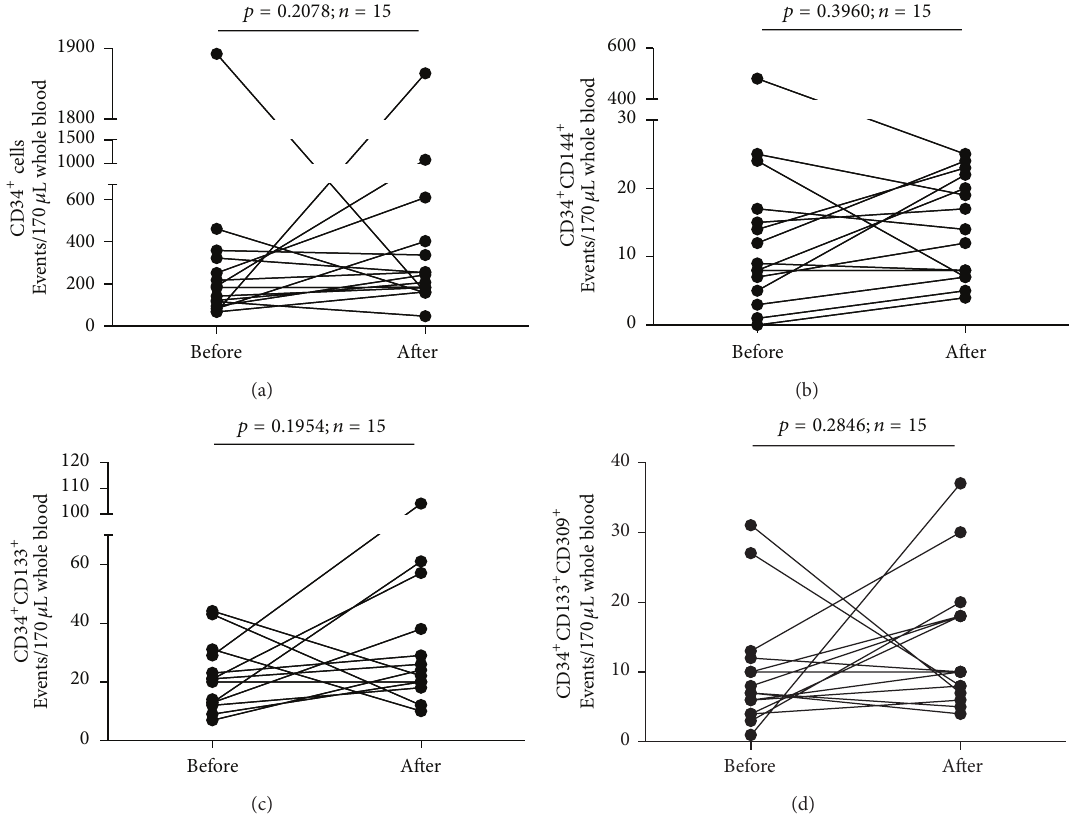
Figure 4: Summary of analyses of time-course changes of the numbers of CD34 + cells (a), CD34 + CD144 + cells (b), CD34 + CD133 + cells (c), and CD34 + CD133 + CD309 + cells (d) in the course of FSH